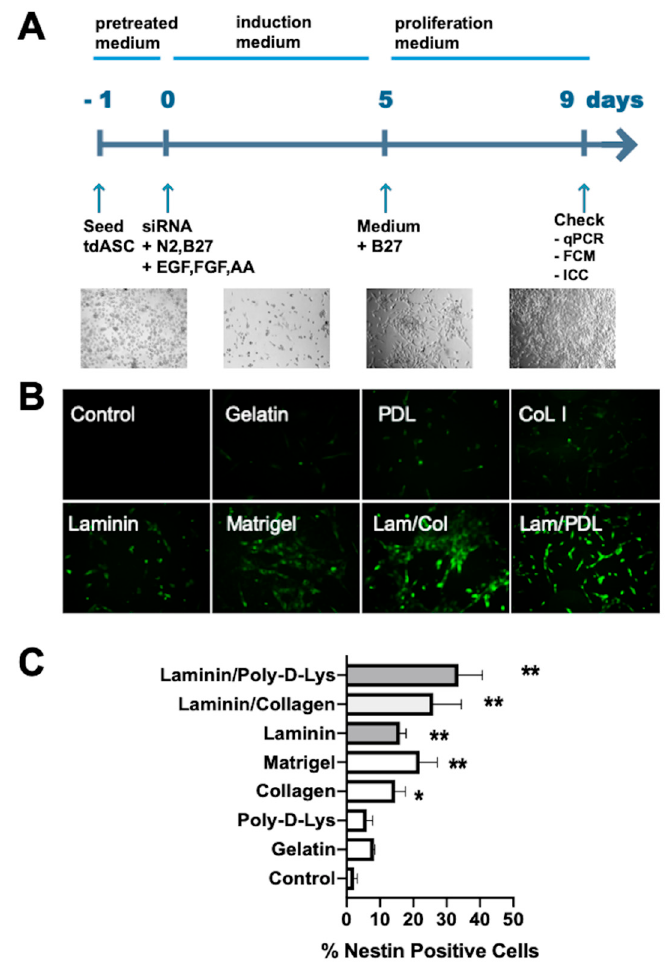
Figure 4. Matrix screen for tdASC-derived NESTIN+ neural progenitor-like cells (iNPLCs). ( A ). Experimental scheme of the generation, expansion, and verification of induced neural progenitor-like cells. ( B ). A panel of images showing representative regions of NESTIN+ cells expanded on gelatin, poly-D-lysine (PDL), collagen I (Col), laminin (LM), Matrigel, LM/Col, and LM/PDL substrates on day 3. ( C ). Values are expressed as the number of NESTIN+ cells per field. n = 6; * P < 0.05; ** P < 0.01; data compared to the control group; data are presented as the mean SEM.